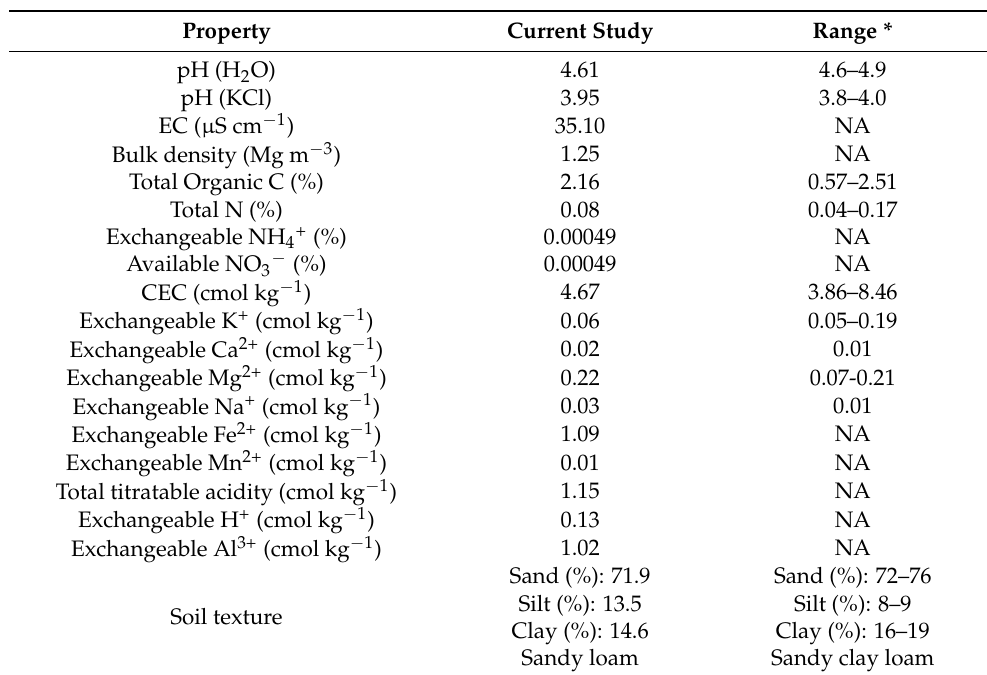
Figure 1. Aerial view of location where the soil sampled in Universiti Putra Malaysia Bintulu Sarawak Campus, Malaysia. Table 1. Selected physicochemical properties of the soil used in the incubation study.